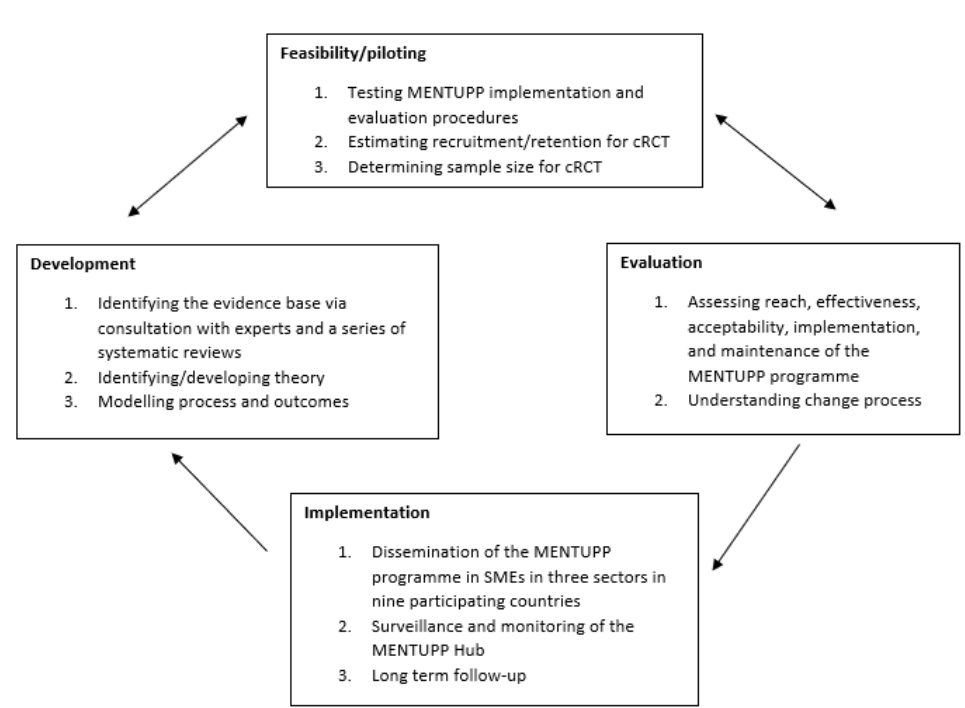
Figure 1. Key elements of the development and evaluation of MENTUPP.